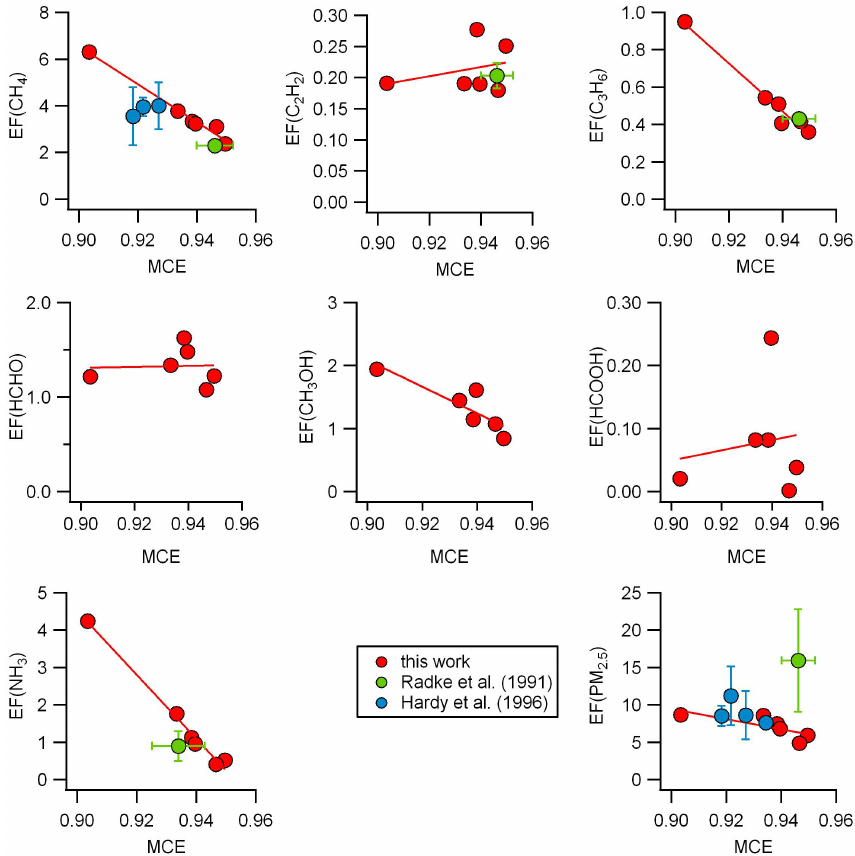
Fig. 2. Emission factors (g kg − 1 ) as a function of MCE for chaparral (coastal sage scrub and maritime chaparral) and oak savanna fires of this study as well as Radke et al. (1991) and Hardy et al. (1996) (interior chaparral). Regression statistics are shown in Table 4. NH 3 was measured in only two of the three chaparral fires of Radke et al. (1991). The MCE and EF(NH 3 ) are based on these two fires (MCE=0.934). The PM of Radke et al. (1991) is of PM 3 . 5 . Regression statistics are shown in Table 4 and apply only to the data collected in this